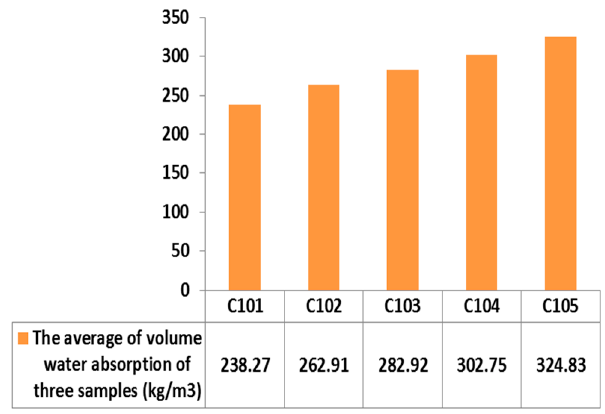
Figure 12. The test results of volume water absorption (kg/m 3 ).